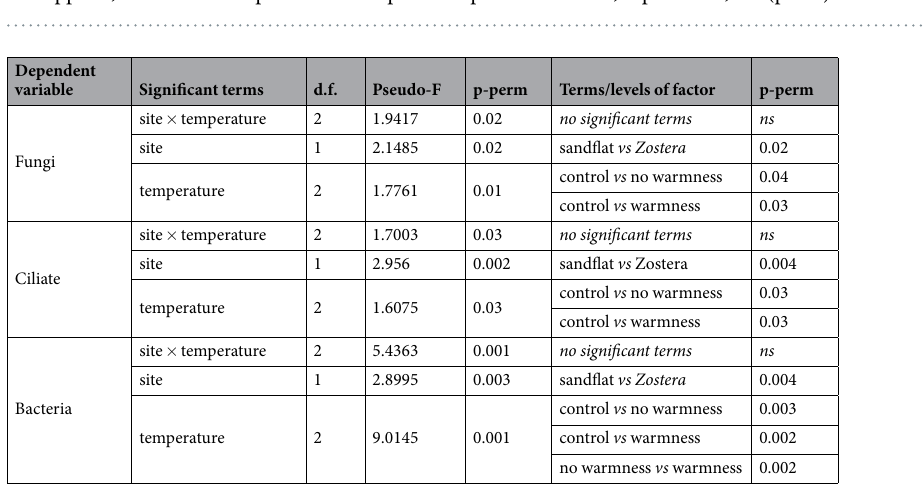
Table 2. Results from the 2-way ANOVA for the effect of site and temperature on fungal, ciliate and bacterial communities’ richness and Shannon-Wiener indices. For the bacterial Shannon-index a 2-way PERMANOVA was applied, as data did not pass the assumptions of parametric tests; a - pseudo-F, b - P(perm).